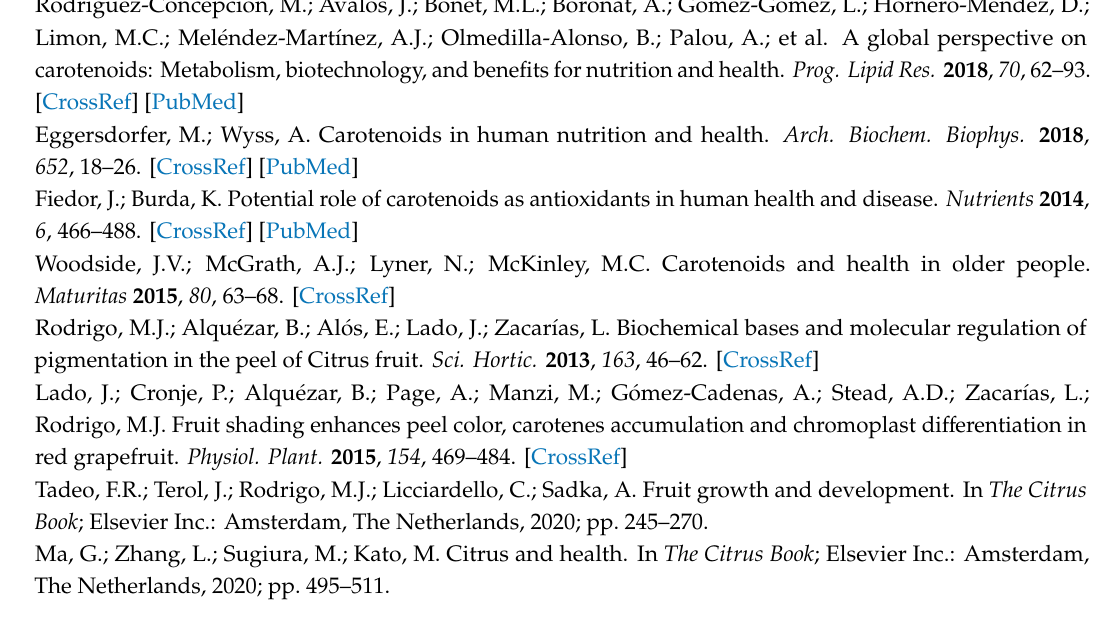
Table S1. qRT-PCR primer sequences, Figure S1. HPLC profiles of saponified carotenoid extracts in pulp of fruits of wild type lemon and pink lemon at mature green stage